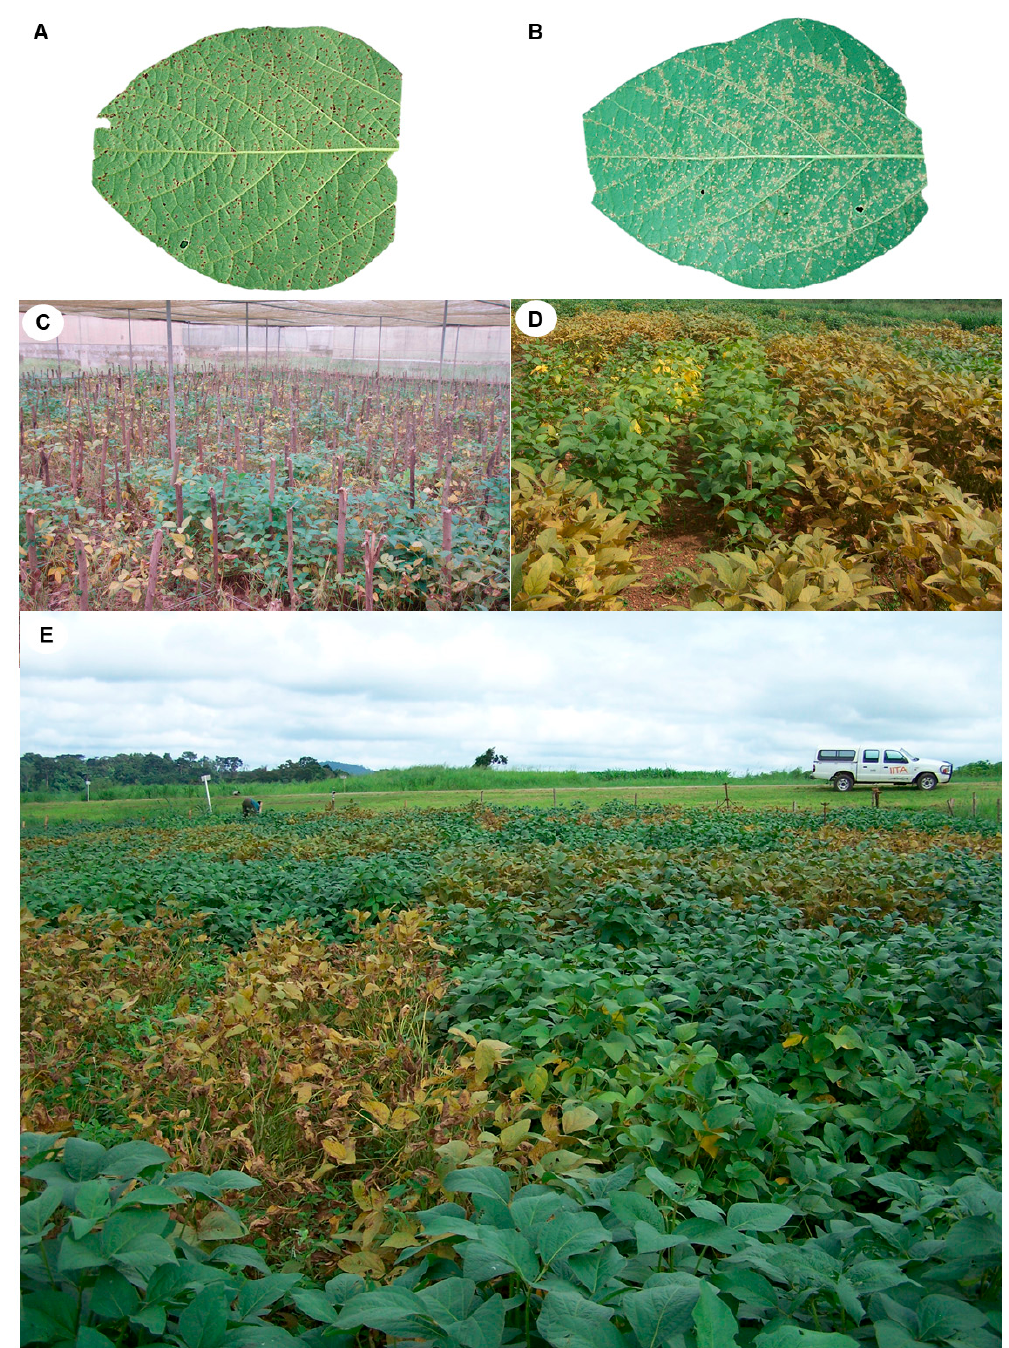
Figure 1. Soybean rust ( Phakopsora pachyrhizi ) symptoms on infected leaves and on whole plants